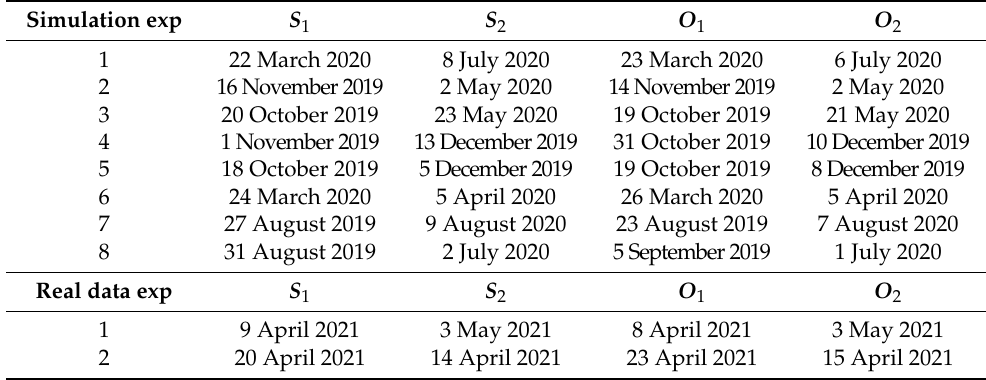
Table 1. Acquisition time of